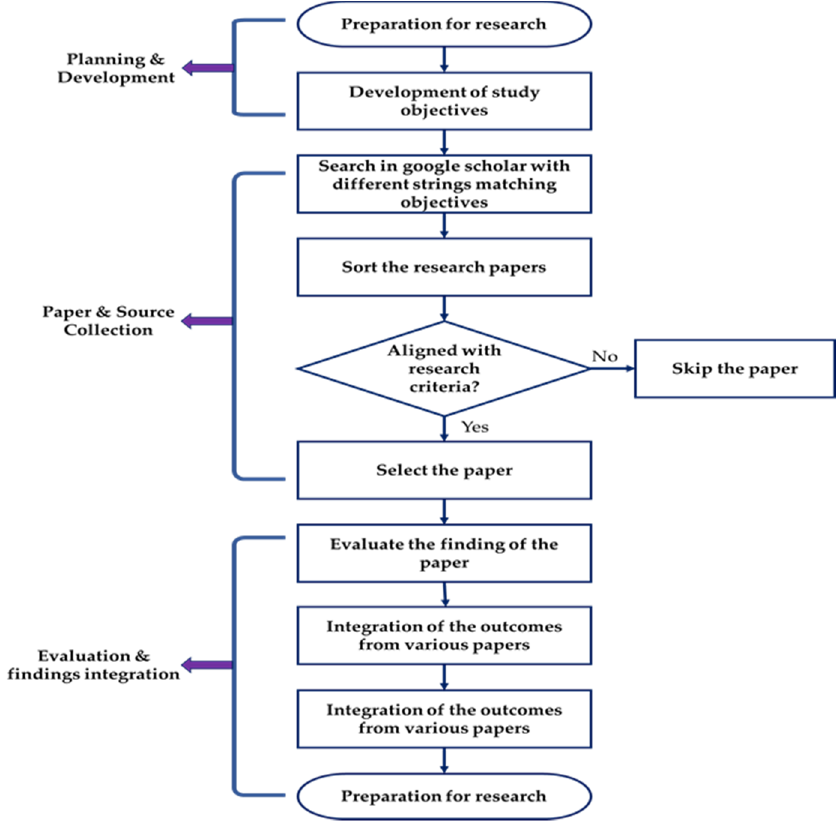
Figure 2. Steps of Systematic Literature Review.